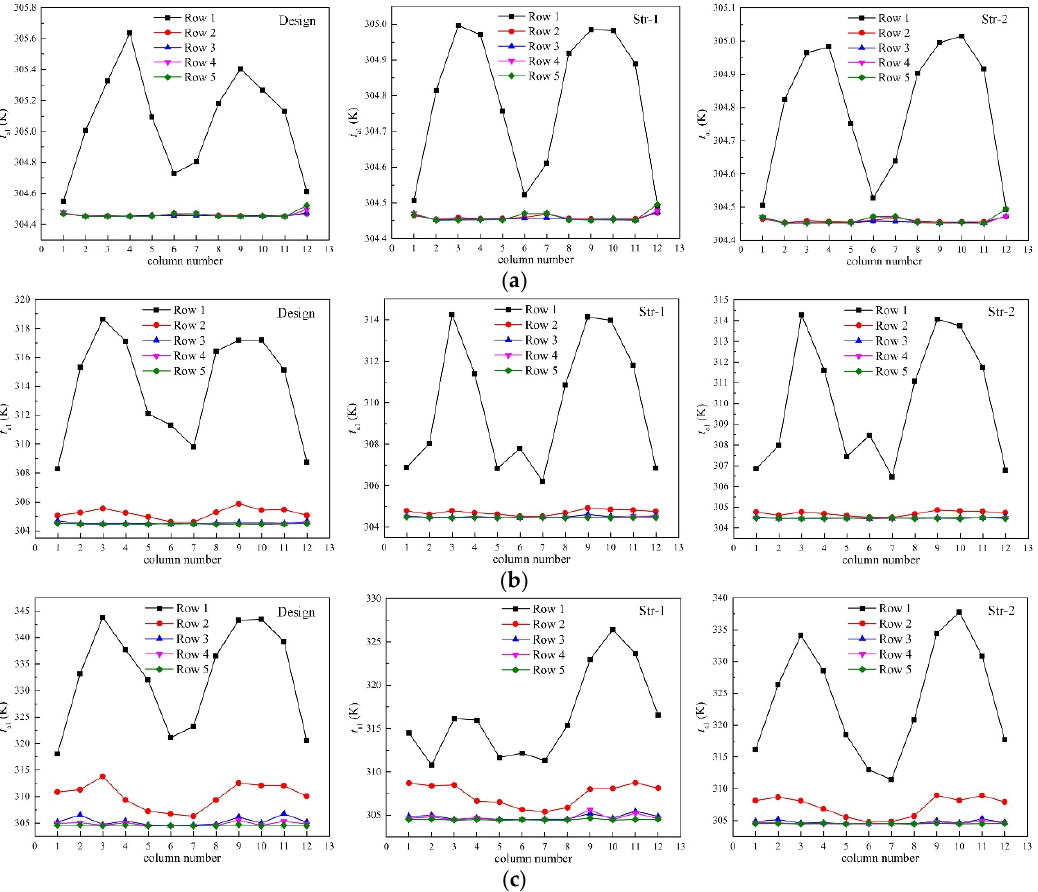
Figure 8. Distribution of inlet air temperatures of the fans at various wind speeds: ( a )4 m/s; ( b ) 12 m/s; ( c ) 20 m/s.